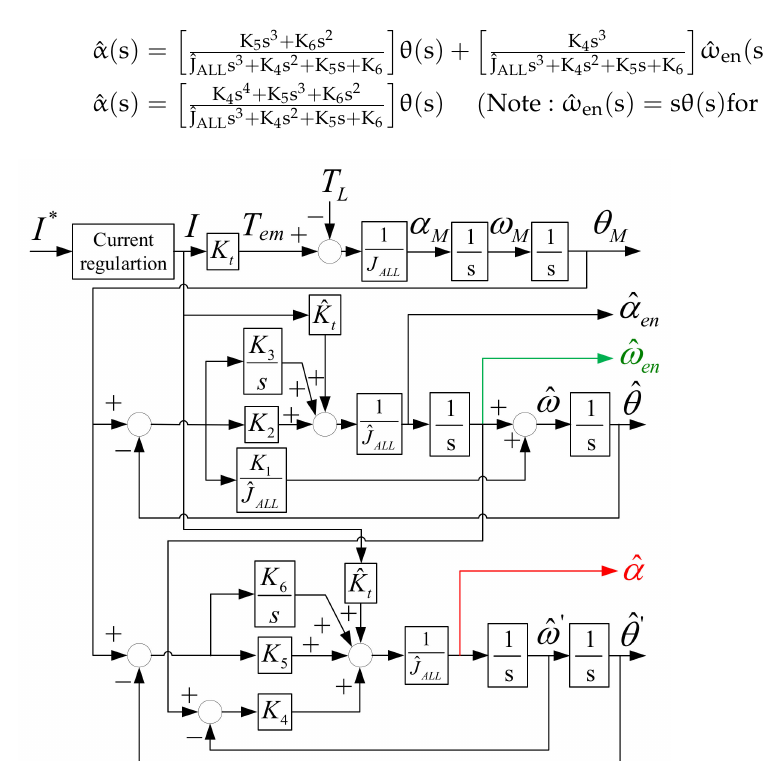
Figure 14. Proposed separated acceleration observer based on the feedbacks of measured position and estimated speed from the prior speed observer in Figure